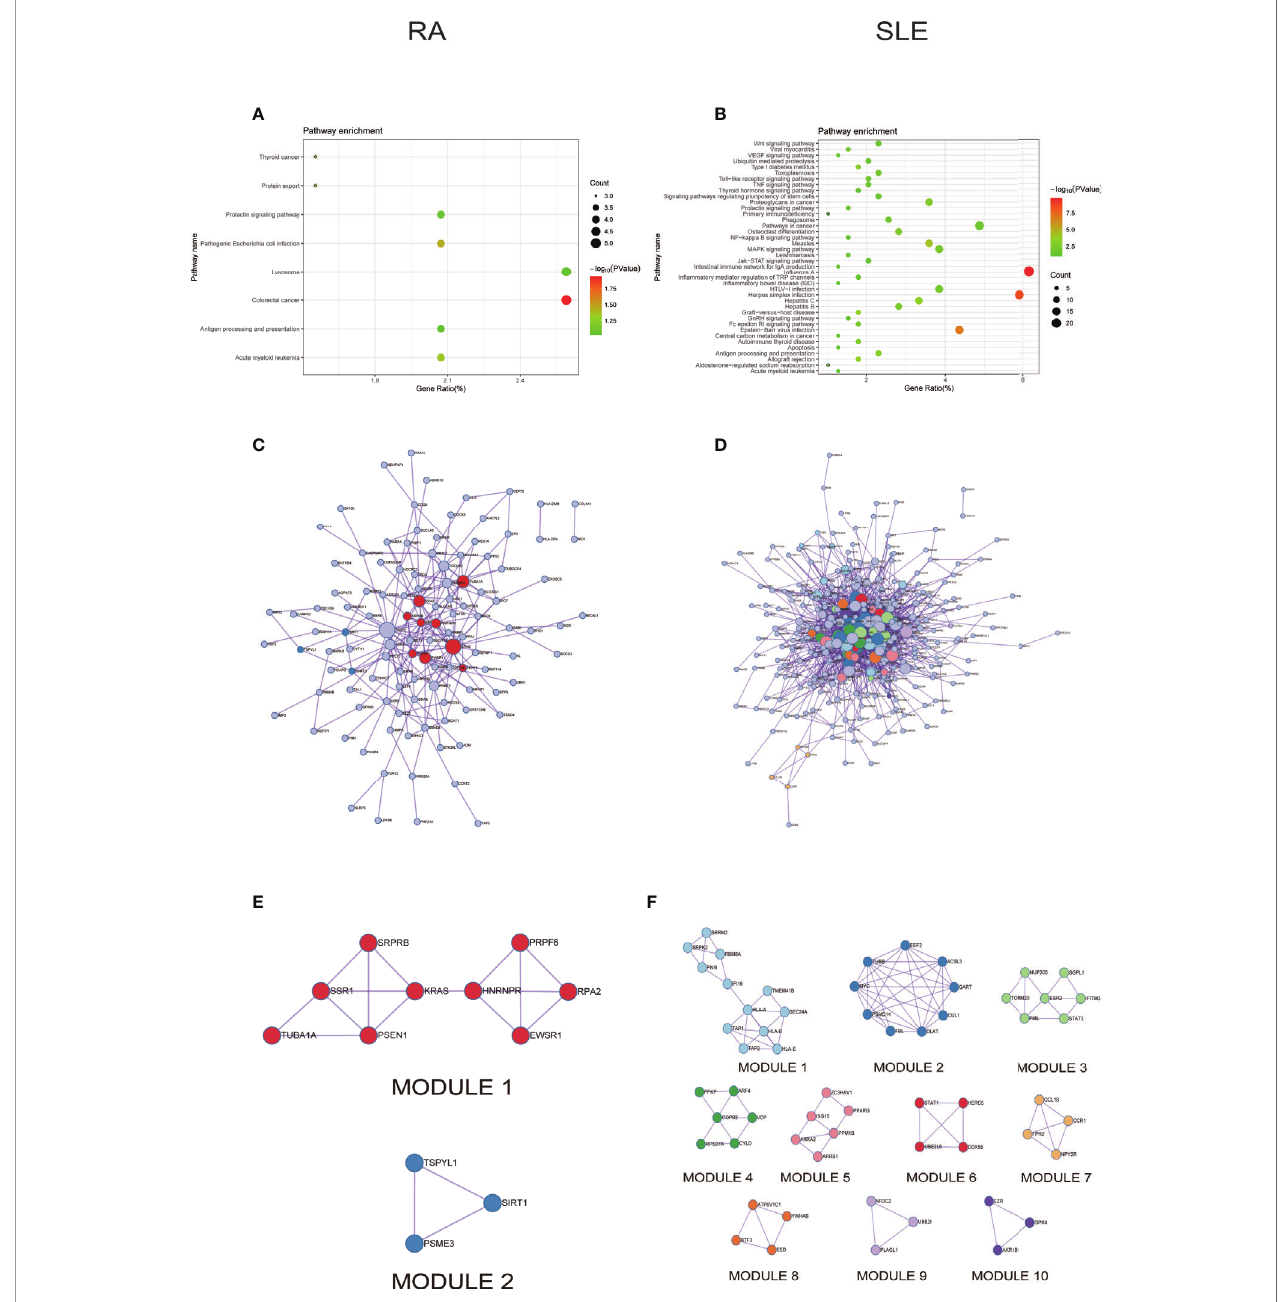
FIGURE 10 | The KEGG pathway analysis, PPI network and the most signi fi cant modules between RA and SLE in CD14 + monocytes. (A, B) The KEGG pathway analysis of RA and SLE; (C, D) The PPI network of CD14 + monocytes was analyzed by String software between RA and SLE; (E, F) The signi fi cant modules of CD14 + monocytes were identi fi ed by MCODE between RA and SLE. DEG, differentially expressed gene; PPI, protein-protein